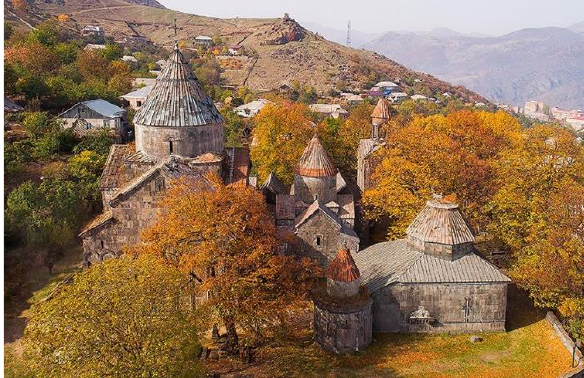
Figure 5. Monastery of Sanahin. ©Andranik Keshishyan 2017.